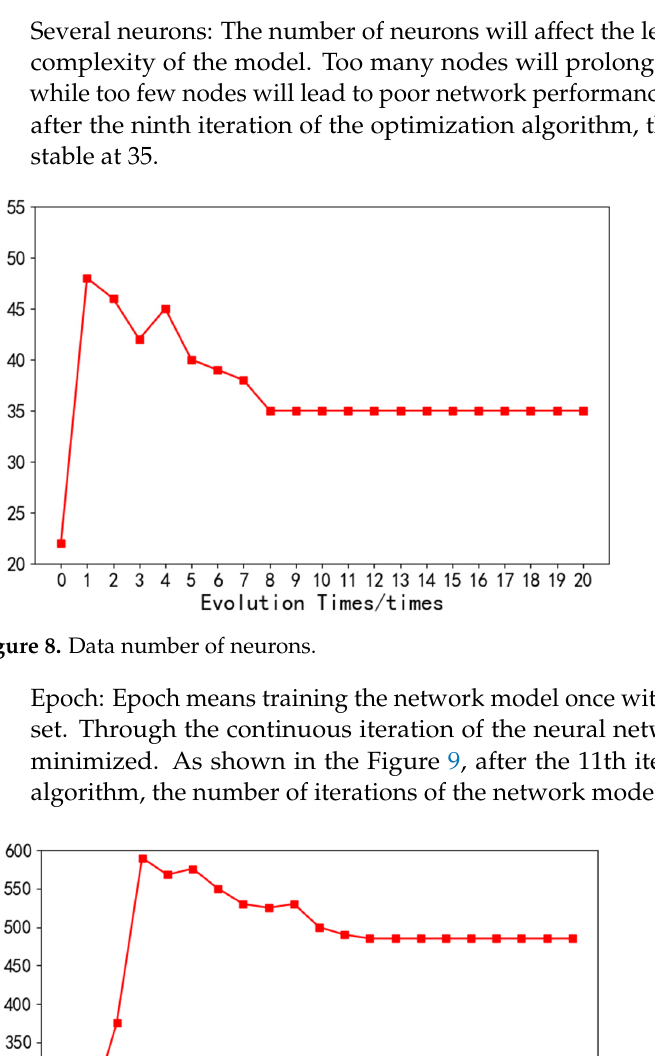
Figure 7. Learning rate of neural network.